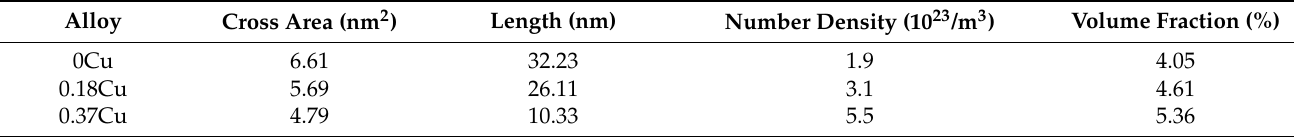
Table 6. Statistical information of the β″ phase of the alloy at peak aging stage.